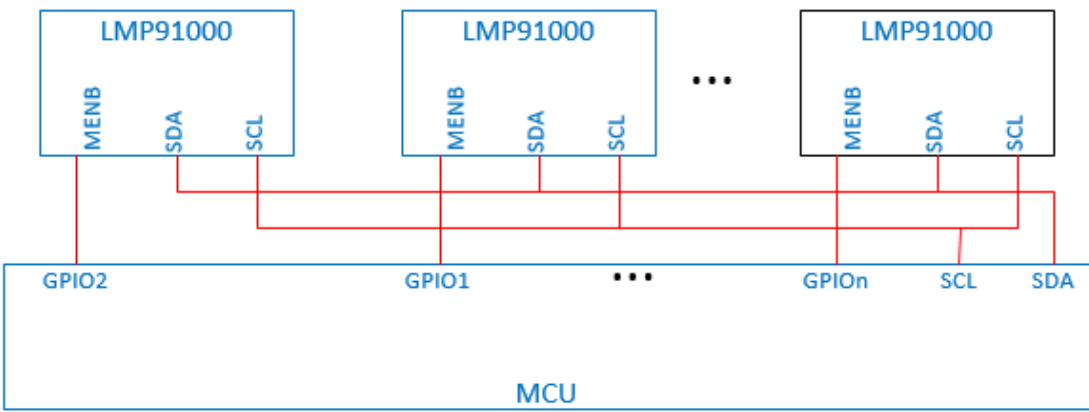
Figure 6. I2C connection mode of multiple LMP91000.